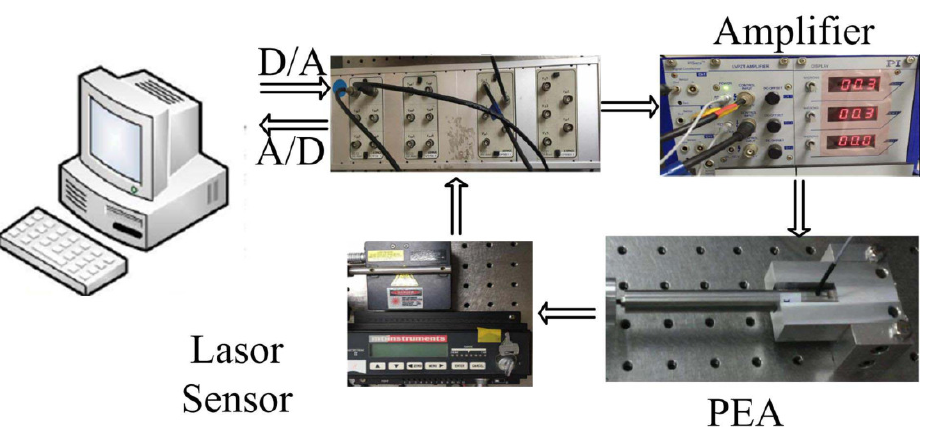
Figure 7. System block